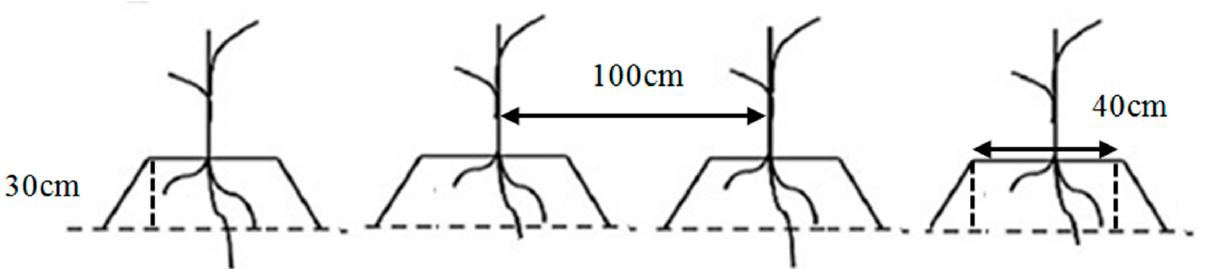
Figure 2. Schematic diagram of ridge tillage.